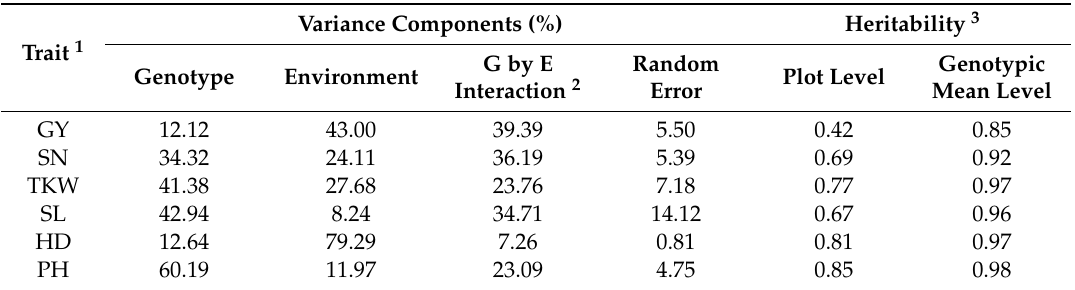
Table 1. Variance components and heritability of yield and yield-related traits in 166 wheat accessions.